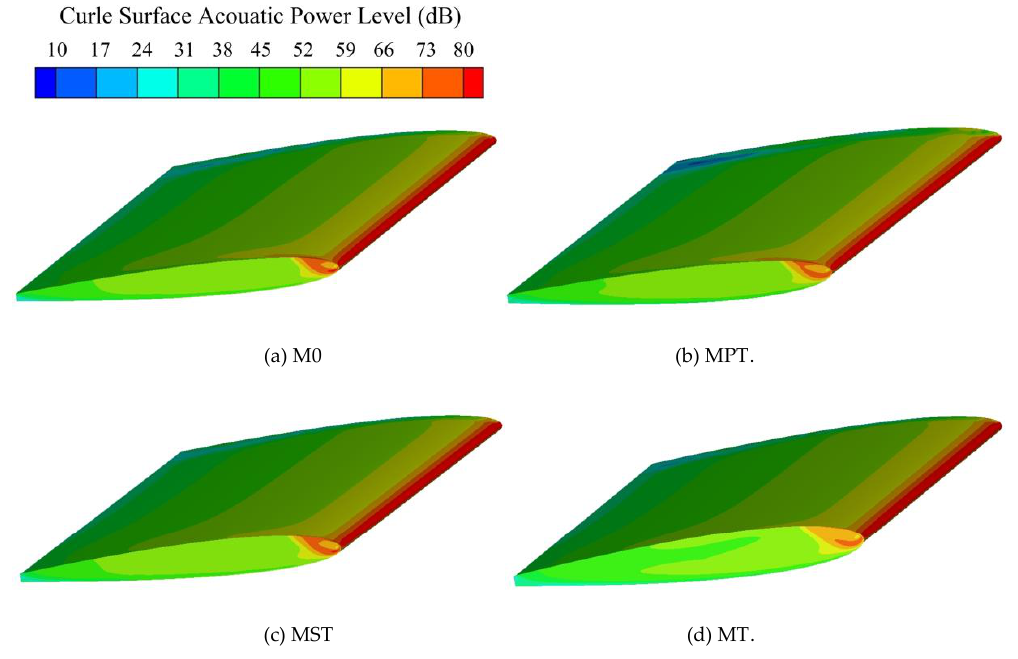
Figure 11. Curle surface acoustic power (SAP) of the hydrofoil for different T-shape tips.